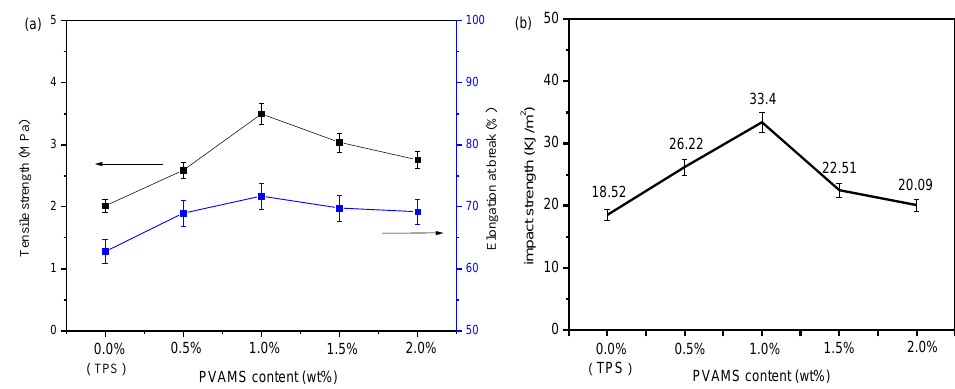
Figure 1. Mechanical properties of thermoplastic starch (TPS) and polyvinyl alcohol microspheres (PVAMS)/TPS composites. ( a ) Tensile strength(in black) and elongation at break(in blue);( b ) impact strength.